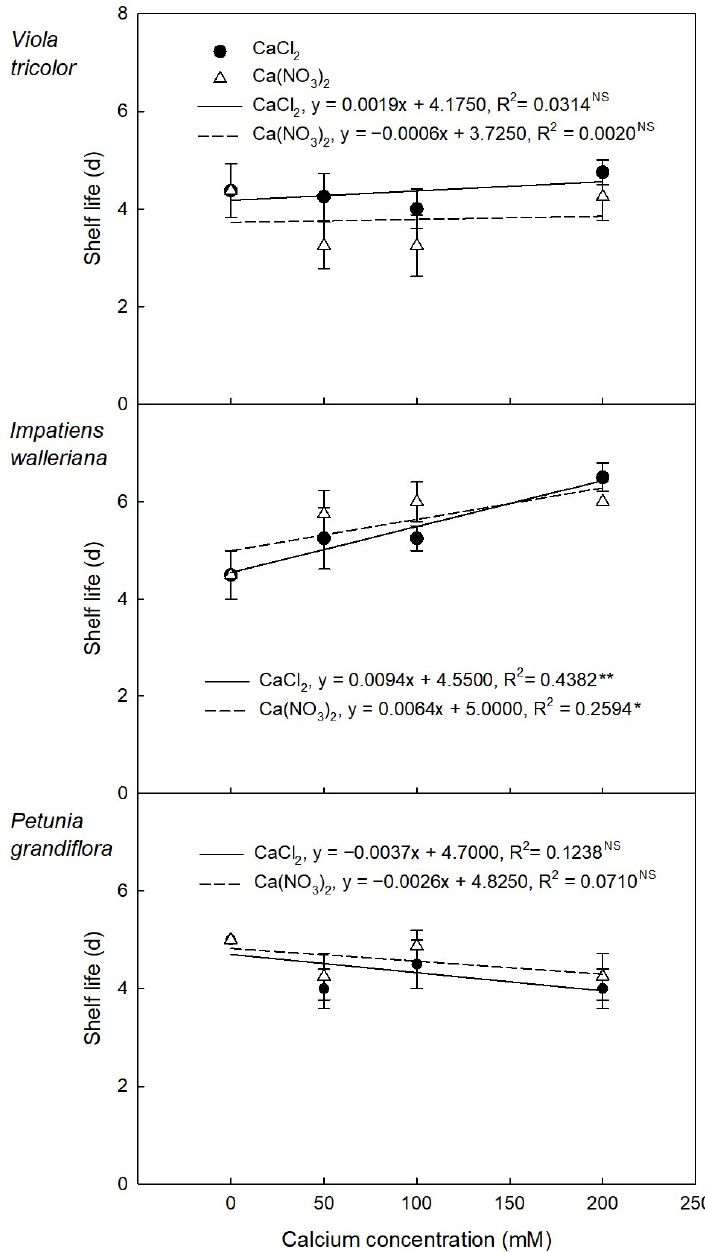
Figure 2. Influence of concentrations of CaCl 2 and Ca(NO 3 ) 2 on shelf life of V. cornuta (viola), I. walleriana (impatiens), and P. grandiflora (petunia) in spray application. Each data point represents the mean of shelf life, but the analysis was performed with all data (n = 4). Bars represent standard error. NS, nonsignificant; *, significant at P ≤ 0.05; **, significant at P ≤ 0.01.